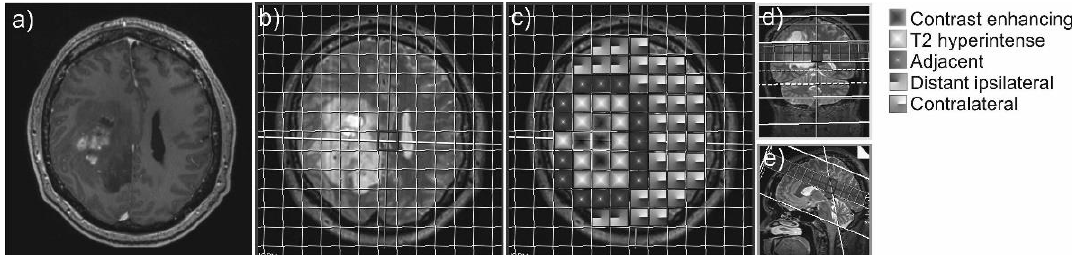
Figure 1. Example of a contrast-enhancing GBM ( a ) and the 31P-MRS measure grid coregistered to the axial T2-weighted sequence of a patient with GBM ( b ). The different areas of interest are coded with different patterns ( c ). On the right side, coronal ( d ) and sagittal ( e ) slices display the position of the voxel slice within the brain.